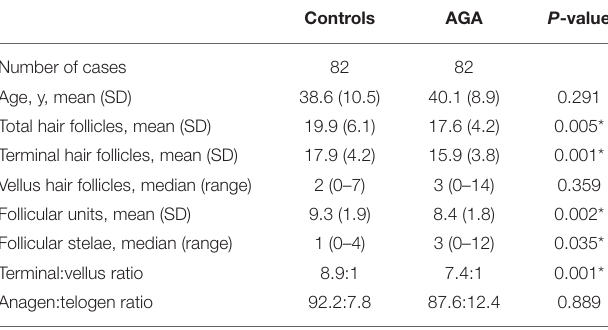
TABLE 1 | Hair counts per 4mm diameter punch biopsy from the occipital scalp of male patients with androgenetic alopecia and controls. Controls AGA